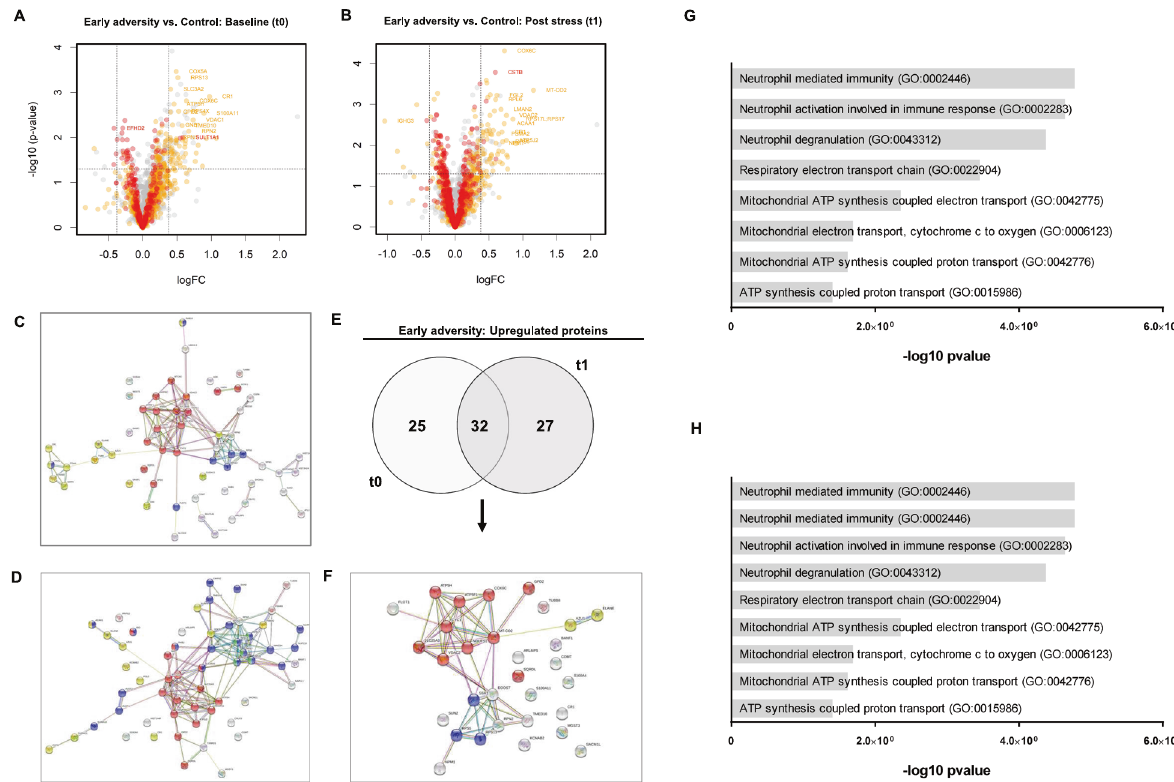
Fig. 2 Differential protein expression between groups before and after stress exposure. Volcano plots compare the extent of log 2 fold- changes (adversity vs. control) and -log 10 p value for protein levels at the t0 baseline measurement ( A : n prot = 1129) and at the t1 post-stress measurement ( B : n prot = 1206). Dashed lines show the |1.3| FC cutoff criterion (vertical) and the 0.05 signi fi cance level (horizontal). Colors in volcano plots re fl ect the 80% (yellow) or 100% (red) validity threshold. Proteins colored in grey did not meet the 80% validity threshold and represent all other proteins. Please note that p values did not survive correction for multiple testing. Protein interaction network structures for proteins upregulated in the early adversity group at t0 ( C ) and t1 ( D ) are depicted. Of all upregulated proteins in the early adversity group, 32 were differentially expressed at t0 and t1 ( E ) and formed a consensus network structure ( F ). Proteins colored in red are associated with mitochondrial biology, and proteins in blue are related to the regulation of protein synthesis and transport. Yellow proteins relate to immune processes and neutrophil degranulation. Green proteins in the t1 network are implicated in viral transcription. Barplots represent signi fi cantly enriched GO-Terms (Top 10 selection for DEP a based on adjusted p-values) for proteins upregulated in the early adversity at t0 ( G ) and t1 ( H ). For network illustrations in higher resolution, see enzyme complex of the respiratory chain (complex IV) as well as subunits of the mitochondrial ATP synthase (ATP5H), the enzyme catalyzing the synthesis of ATP as universal intracellular energy carrier through phosphorylation. Of all 92 DEPa, 26 (28%) are referenced in MitoCarta 3.0 as mitochondrial (Table S7) and functionally linked to, e.g., the oxidative phosphorylation pathway ( n prot = 9) or mitochondrial metabolism ( n prot = 11). Among the proteins that associate with a role in protein-related processes, two are part of the 40 s ribosomal subunit (RPS13, RPS5) and function in protein synthesis, while DDOST, SSR1, and RPN2 play part in protein translocation. These results were stable when using different imputation methods applied to the data to replace missing values (Figure S3). GO-terms associated with upregulated DEP a identi fi ed at t0 ( n = 57) and t1 ( n = 59) are depicted in Fig. 2G, H. Exploring pairwise semantic similarities between all GO-terms associated with t0 and t1 DEP a , we built ten cluster solutions of biological processes (Figure S4) upregulated in the early adversity group. Upregulated processes indicate that childhood adversity was associated with altered cell-type speci fi c functions such as monocyte activation (GO: 0042117) and antimicrobial processes (GO: 0002777), accompanied by elevated signaling (GO: 0002777) and regulation of the cell ’ s motility (GO: 0002777), as well as with altered housekeeping processes such as homeostasis (GO: 0033762) and energy metabolism (GO: 0042773). Results further